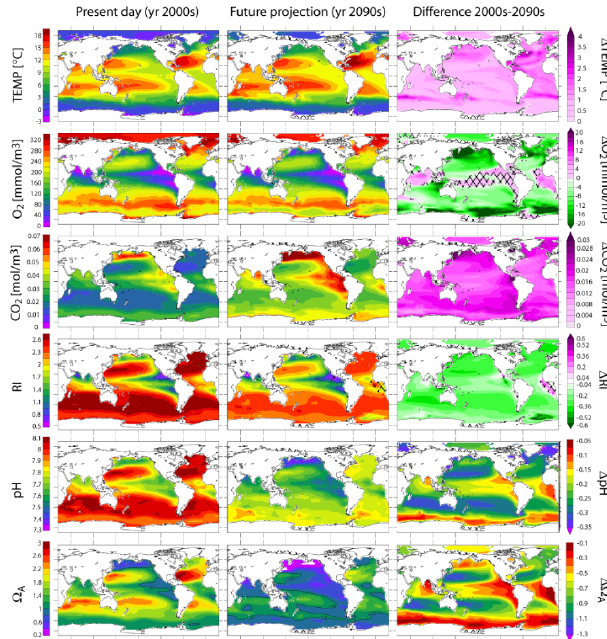
Fig. 4. Current and projected temperature, O 2 , CO 2 , RI, pH, and (cid:127) A (100–600m depth average). Observation-based fields from GLODAP and WOA 09 are shown on the left. The second col- umn shows the projected 2090s distributions under the SRES A2 scenario, calculated as the sum of the observation-based fields and the 1990–2100 multi-model mean changes. The panels on the right represent the differences between the second and the first column. Hatched areas indicate where less than five out of seven models agree in the sign of the projected change. The contours represent the thresholds RI = 1 and (cid:127) A =